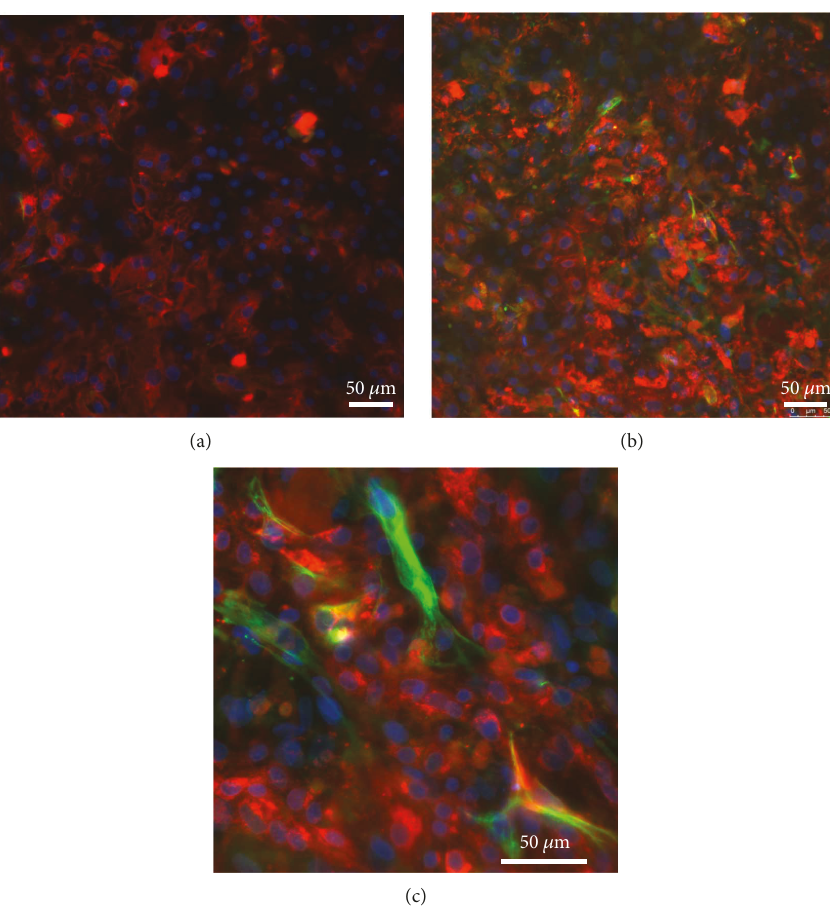
Figure 8: Distribution of porcine hepatocytes and human MSC in coculture. Cells were cultured for 2 days and then serum-starved to avoid nonspeci fi c staining. Immuno fl uorescence was performed on cells after 3 days of culture. (a) Hepatocytes are stained for porcine albumin (in red). (b) Coculture of hepatocytes and MSC. MSC are stained for human vimentin (in green). (c) Coculture of hepatocytes and MSC in a higher magni fi cation ( × 40). Images are representative of 2 independent pig hepatocyte